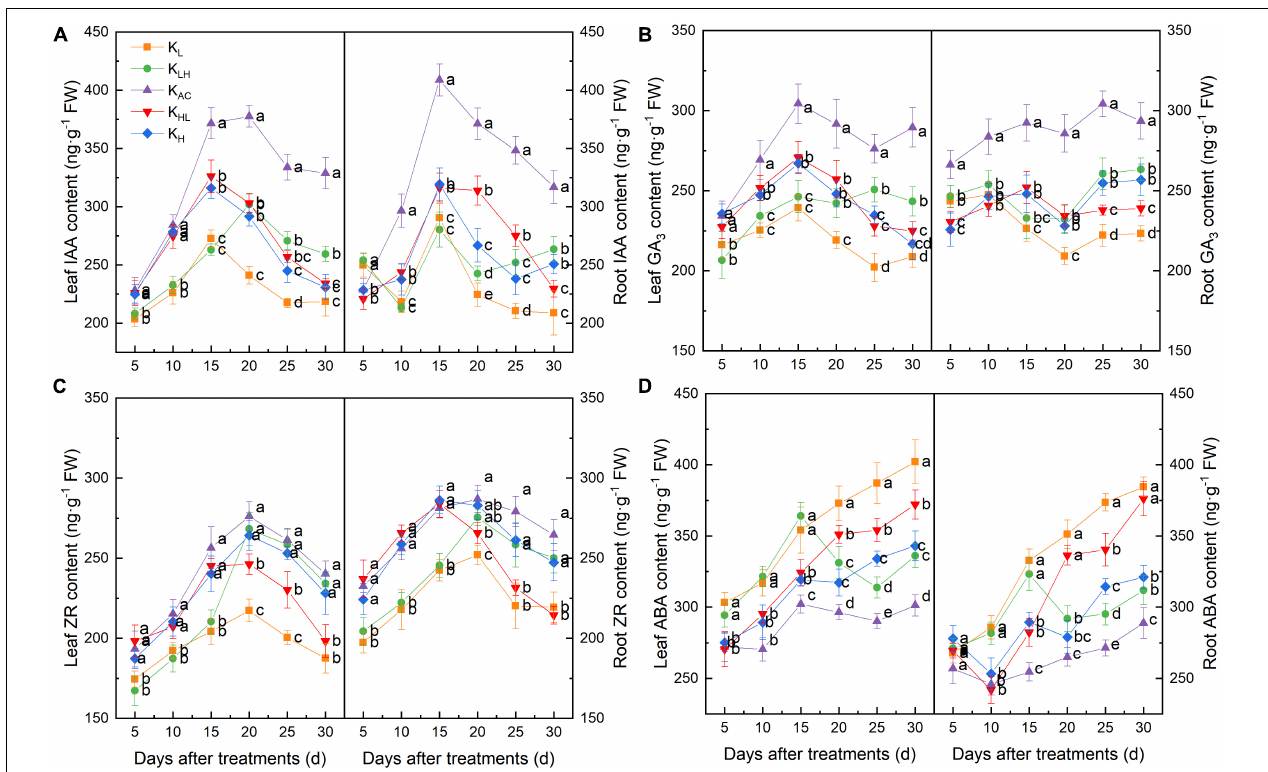
FIGURE 2 | Effect of different K treatments on endogenous hormone content in roots and leaves of M9T337 rootstocks. Content of (A) IAA, (B) GA 3 , (C) ZR, and (D) ABA. Data show the means ± standard deviation of three independent samples. Different letters on vertical bars indicate significant differences ( P <